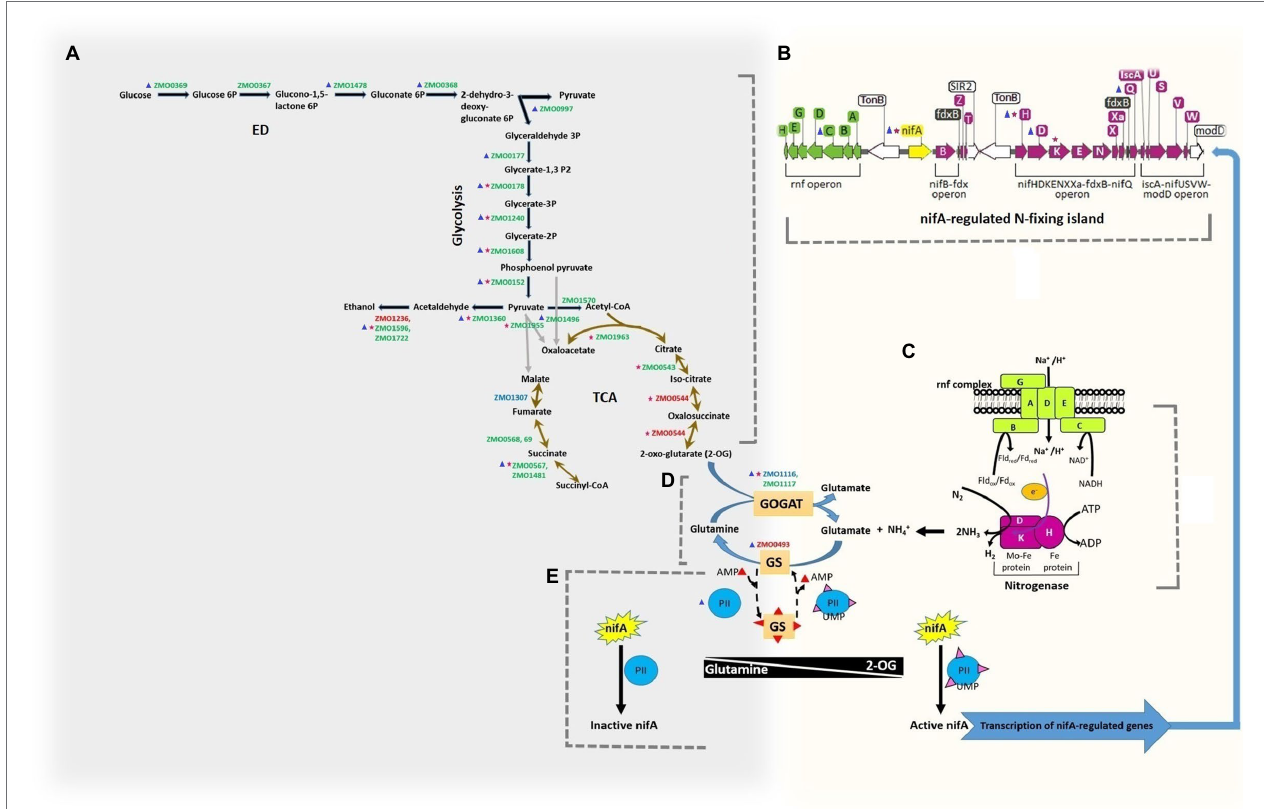
FIGURE 7 | Regulation and acetylation of proteins in metabolic pathways of central carbon metabolism and nitrogen fixation in Z. mobilis in the present study. On the left side (A) the Entner–Doudoroff (ED) pathway, glycolysis, ethanol fermentation pathway and TCA cycle are shown. On the right side, nifA -regulated N-fixing island (B) and nitrogen fixation (C) are shown. Both of the metabolic circuits are connected in the center (D) by the ammonia assimilation pathway (GS/GOGAT cycle). At the bottom (E) the regulation of nitrogen fixation is depicted, where nifA acts as a master regulator to control the expression of nitrogen-fixing genes, and the activities of GS and nifA are putatively regulated by PII regulatory proteins. Whereas, concentrations of the regulatory metabolites glutamine and 2-oxoglutarate (2-OG) putatively regulate the interactions of PII proteins by their uridylylation (PII-UMP). The gene IDs in red color represent the up-regulated proteins, in blue color represents the downregulated proteins, and in green color represents the proteins that were not expressed differentially. The differentially acetylated proteins are shown with a small star in red color. The phosphorylated proteins (Tatli et al., 2019) are shown with a small triangle in blue color. All the pathways, reactions, and metabolites are consistent with the KEGG database record of Z. mobilis